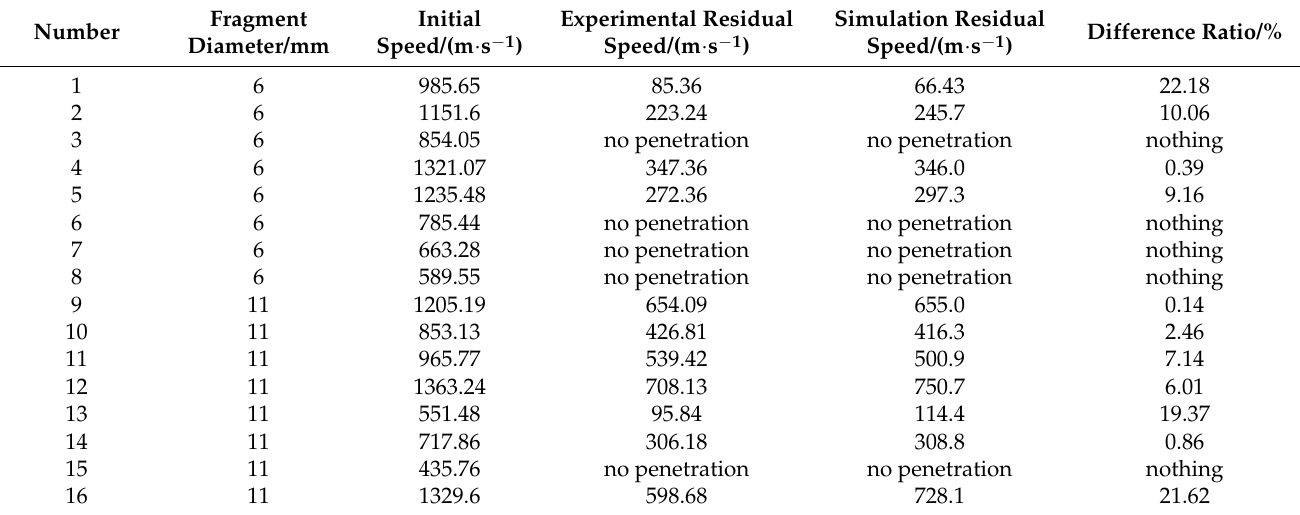
Table 3. Comparison of residual velocities of 6 mm and 11 mm